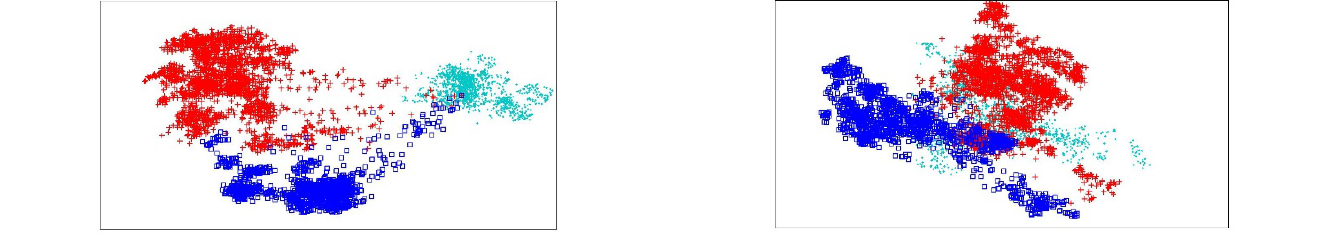
A case of traditional multidimensional scaling connected to voting designs in the United States House of Representatives. Every red spot speaks to one Republican individual from the House, and each blue dab one Democrat.